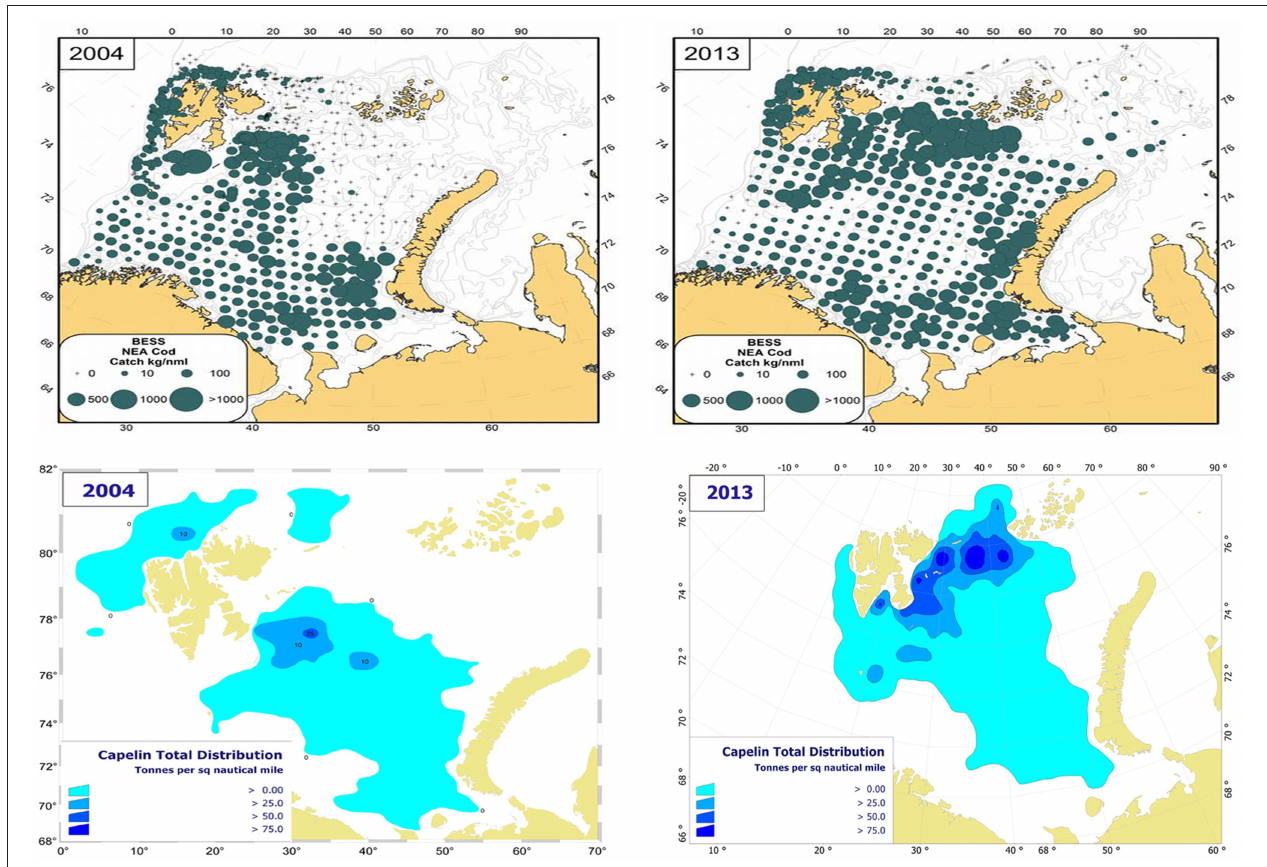
FIGURE 5 | Spatial distribution of cod (upper panels) and capelin (lower panels) in August-September 2004 and 2013, from the Norwegian-Russian ecosystem survey. Cod: bottom trawl catches (kg/nm), capelin: acoustic estimates (tons/nm 2